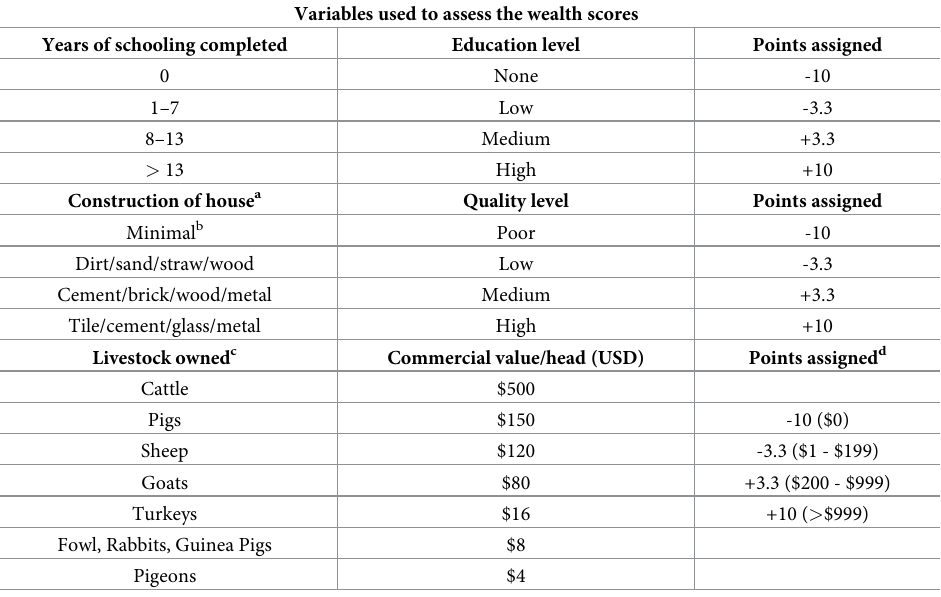
Table 1. Construction of wealth